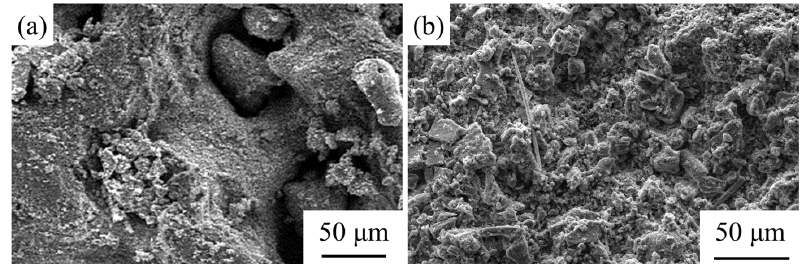
Figure 4. The SEM images of untreated and GBFS-treated coral aggregate: ( a ) untreated coral aggregate and ( b ) coral aggregate treated with GBFS.